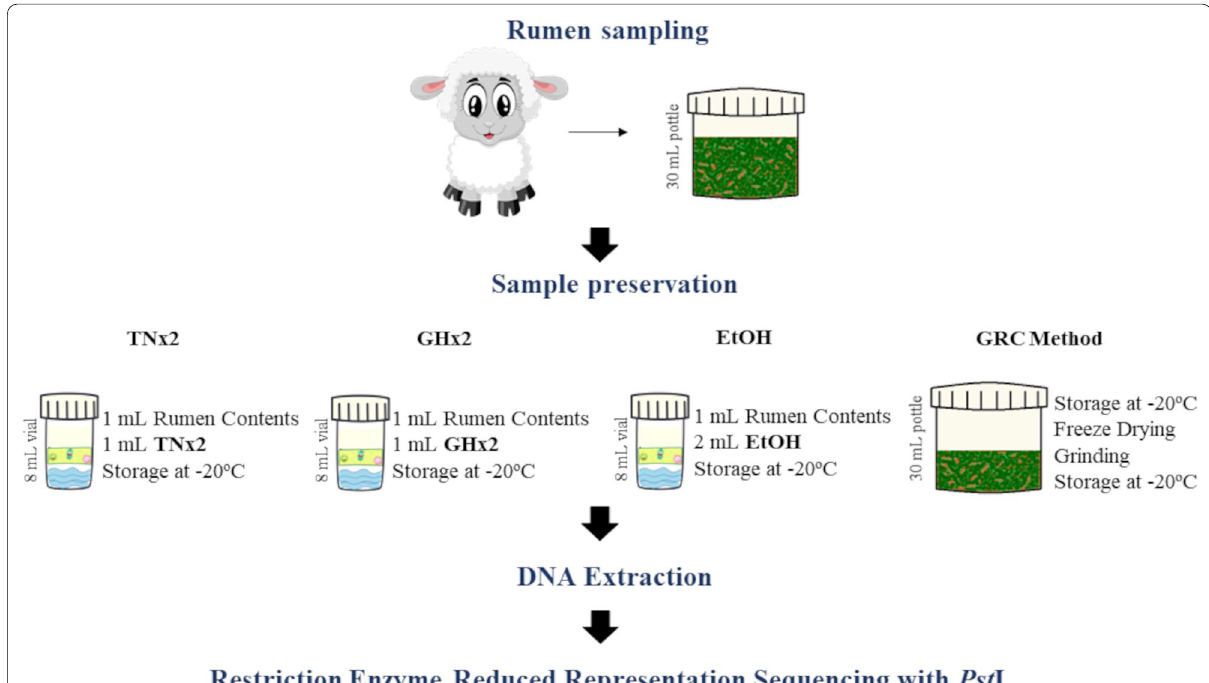
Fig. 1 Schematic showing sampling, subsampling and processing of ruminal samples by the four preservation